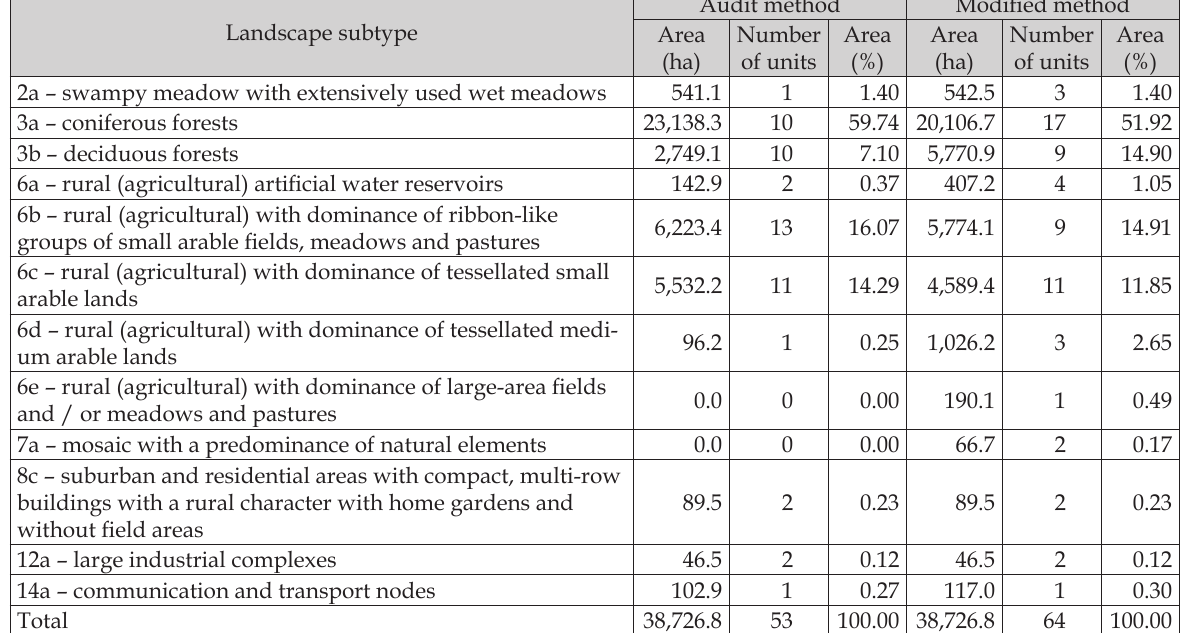
audit method and the modified method. Table 1. Characteristics of landscapes